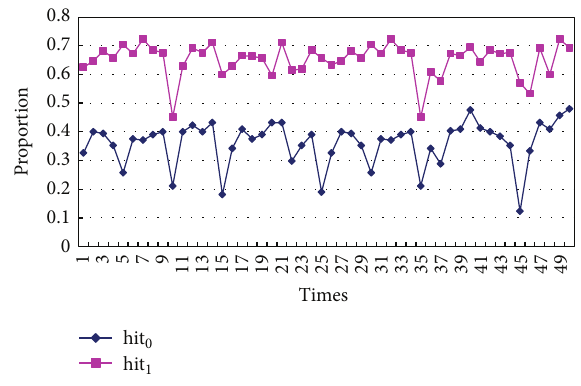
Figure 3: Performance of multinomial logistics regression. Table 6: Goodness-of-fit measures of the best logistic regression model. 𝜒 2 DF Sig. Pearson 401.191 360 0.066 385.701 360 0.168 Table 7: Performance comparison. hit 0 hit 1 Rough set